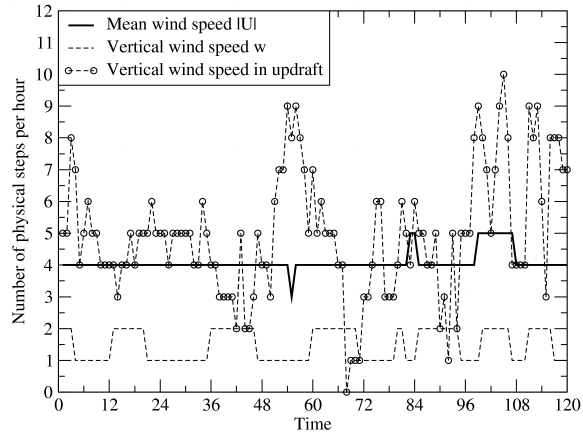
all pro- Fig. 2. General CHIMERE structure for time integration of